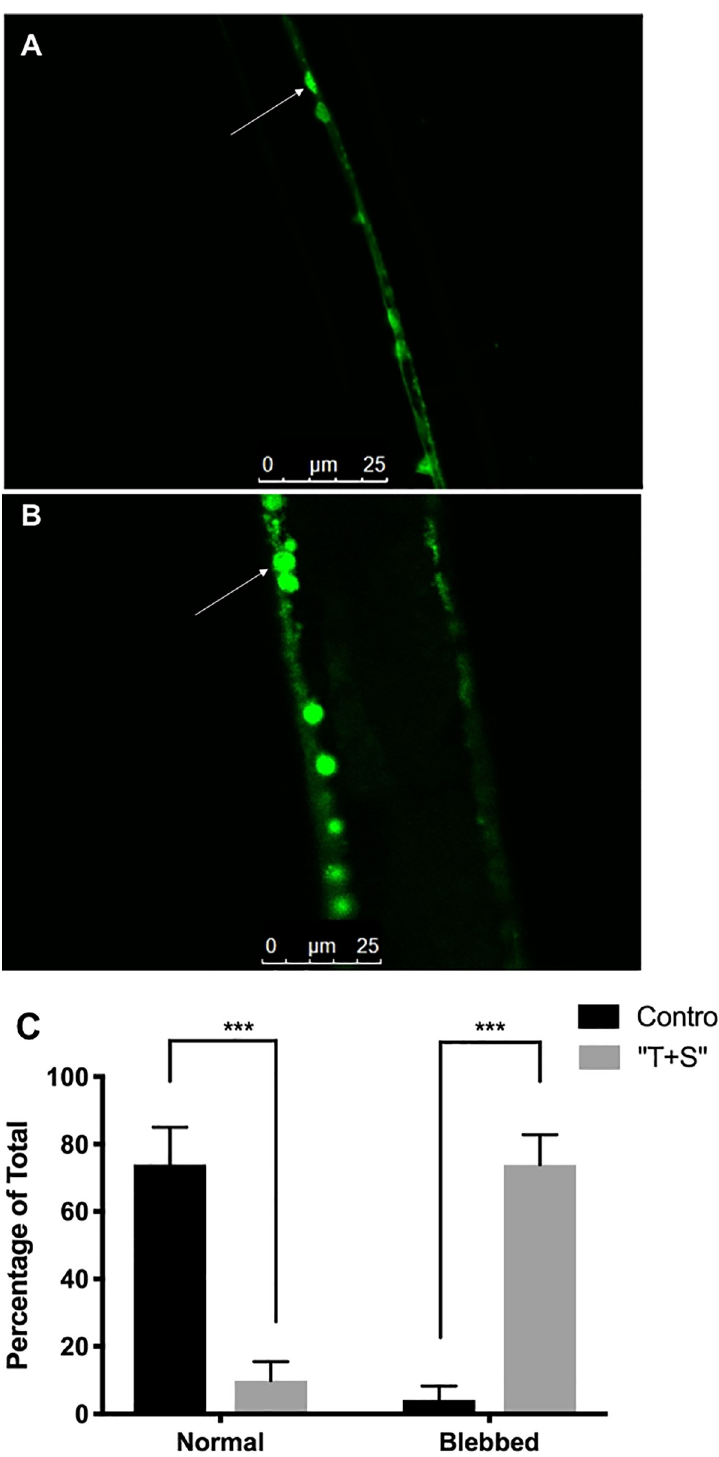
Fig 10. “T+S” exposure leads to neurodegenerative changes in cholinergic neurons. Strain LX929 C . elegans , which express GFP in all cholinergic neurons, were raised on either control plates (A) or ones with full-strength “T+S” (B), up to L4 stage. C . elegans were then transferred to agarose gel pads, immobilized with NaN 3 , and imaged through confocal microscopy. (C) Treated worms had a significantly higher percentage of blebbed neurons, a noted sign of aging, than did untreated worms, and untreated worms had a significantly higher percentage of normal, non-blebbed neurons ( p < 0.0001 for both). Indeterminable neurons were excluded from analysis. https://doi.org/10.1371/journal.pone.0238637.g010 PLOS ONE | https://doi.org/10.1371/journal.pone.0238637 September 9,